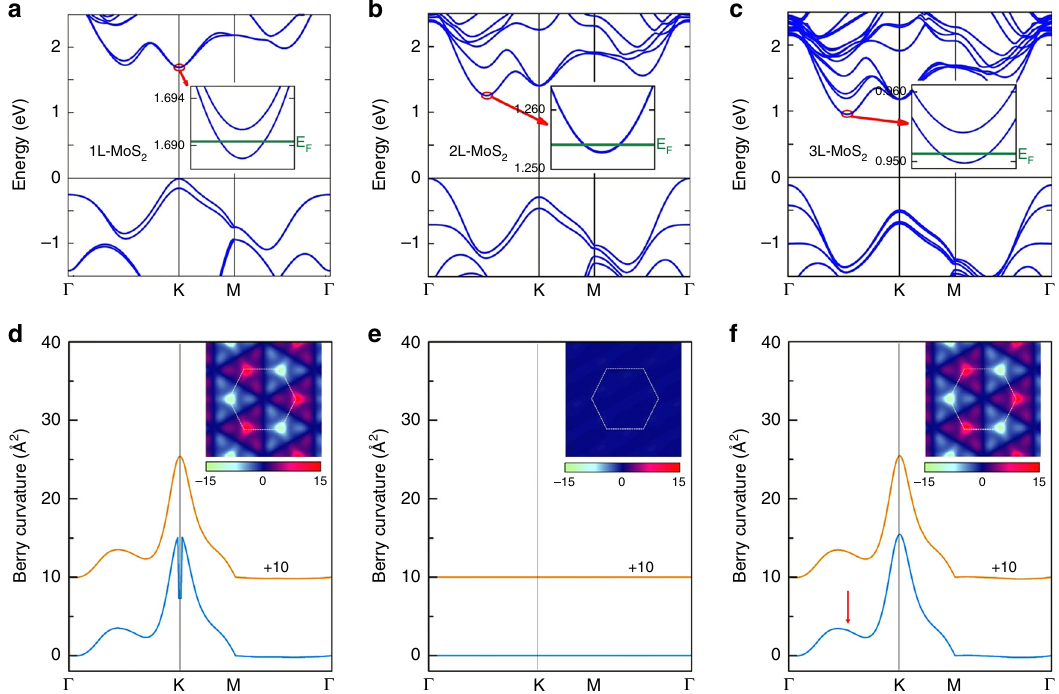
Fig. 4 Band structures and Berry curvatures of atomically thin MoS 2 . a – c Band structure of ( a ) monolayer, ( b ) bilayer, and ( c ) trilayer MoS 2 . The conduction band edges lie at the K-valleys in the monolayer but at the Q-valleys in the bilayer and trilayer. Insets of a – c : The Fermi levels only cross the lowest sub-bands, which are spin degenerate in b but spin split in a and c . d – f Berry curvatures of d monolayer, e bilayer, and f trilayer MoS 2 . The blue curves are the total curvatures of all occupied states below the Fermi levels (~2 meV from the conduction band bottom), whereas the orange curves are the total curvatures of all valence-band states. The red arrow in f points out a tiny bump at a Q-valley. Insets of d – f 2D mapping of Berry curvatures in the 2D Brillouin zone (white dashed